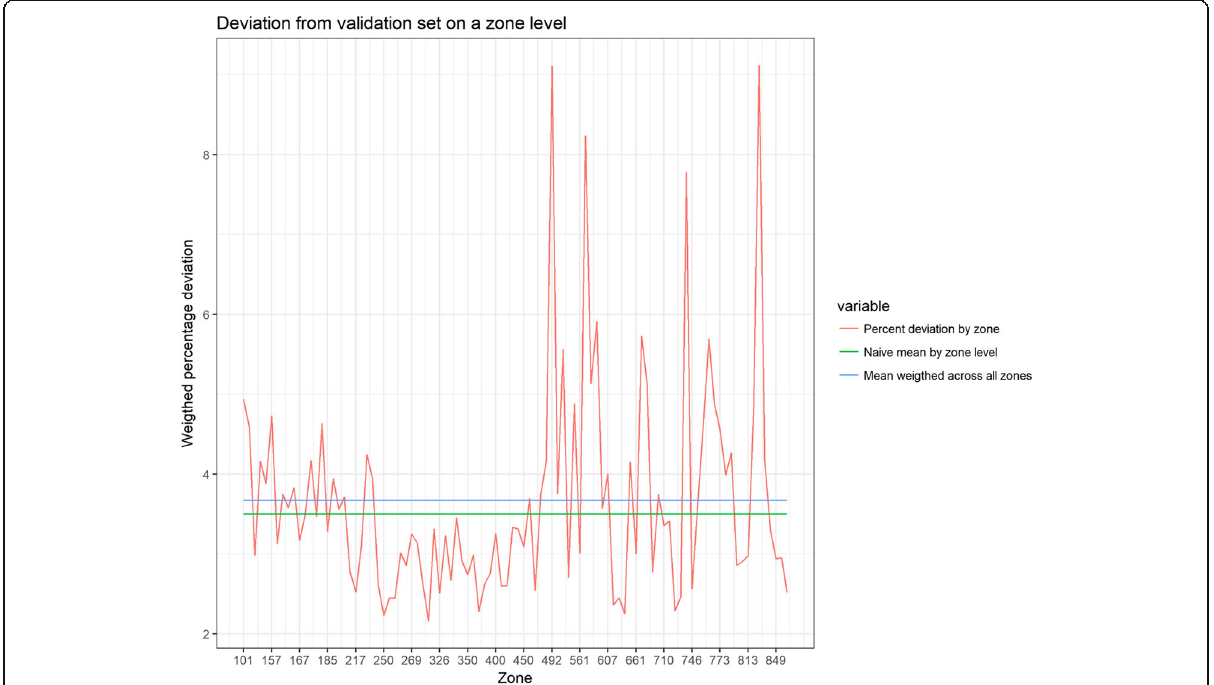
Fig. 7 Weighted percentage subzone deviation of predicted population from 2010 to 2015